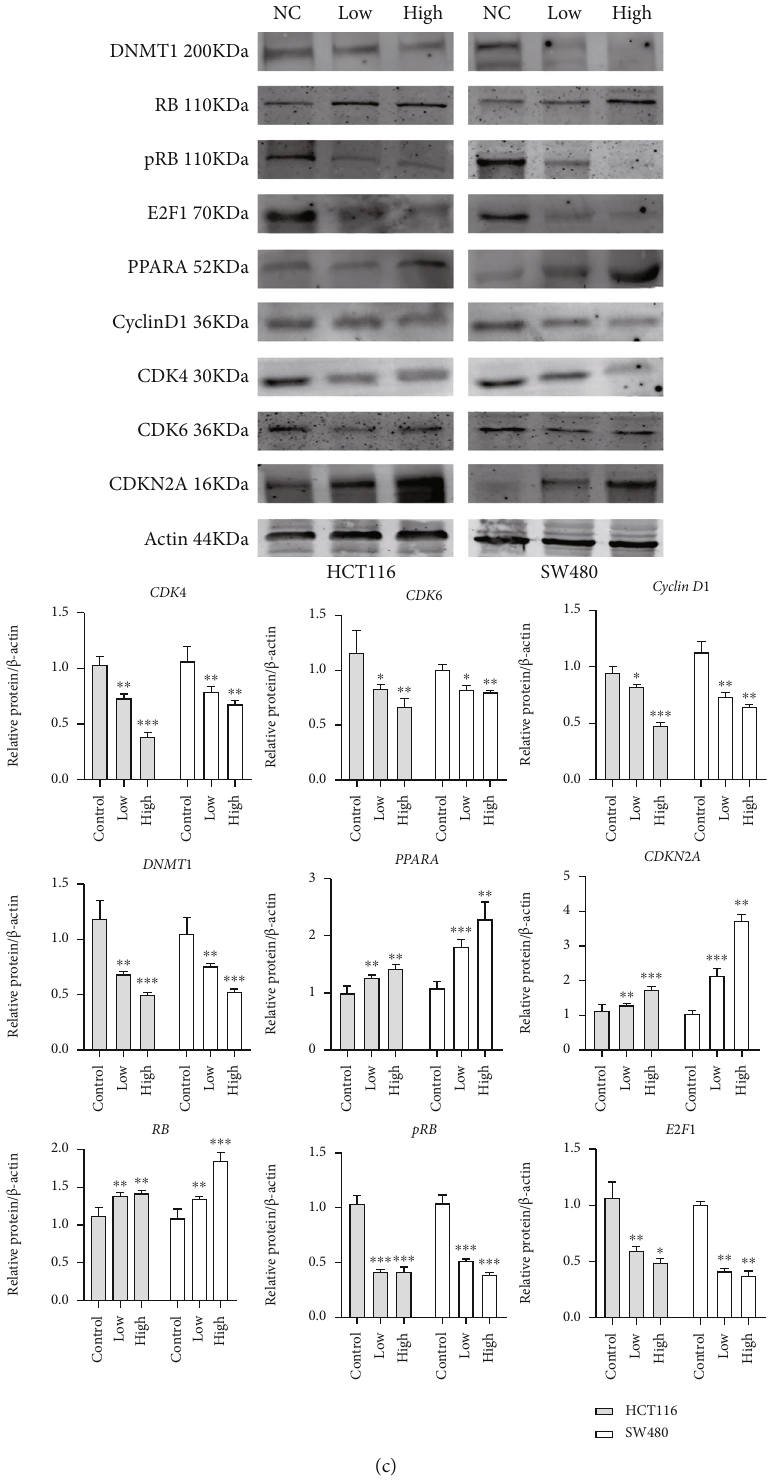
Figure 7: Feno fi brate modulated cell cycle via CDKN2A/RB/E2F transcript cascade. (a) Cell cycle distribution was examined using fl ow cytometry. (b) The mRNA expression of RB, E2F1, CDK4, CDK6, and Cyclin D1 was measured using qRT-PCR. Data was presented as mean ± SD ( ∗ P < 0 : 05 , ∗∗ P < 0 : 01 , ∗∗∗ P < 0 : 001 ). (c) Western blot analysis of DNMT1, RB, pRB, E2F1, PPARA, Cyclin D1, CDK4, CDK6, and CDKN2A expression in colon cancer